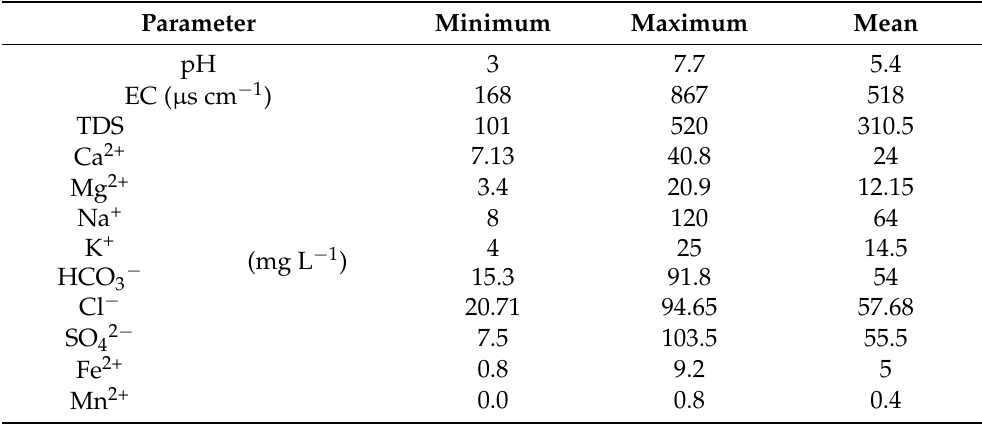
Table 2. Physicochemical properties of groundwater dataset: a